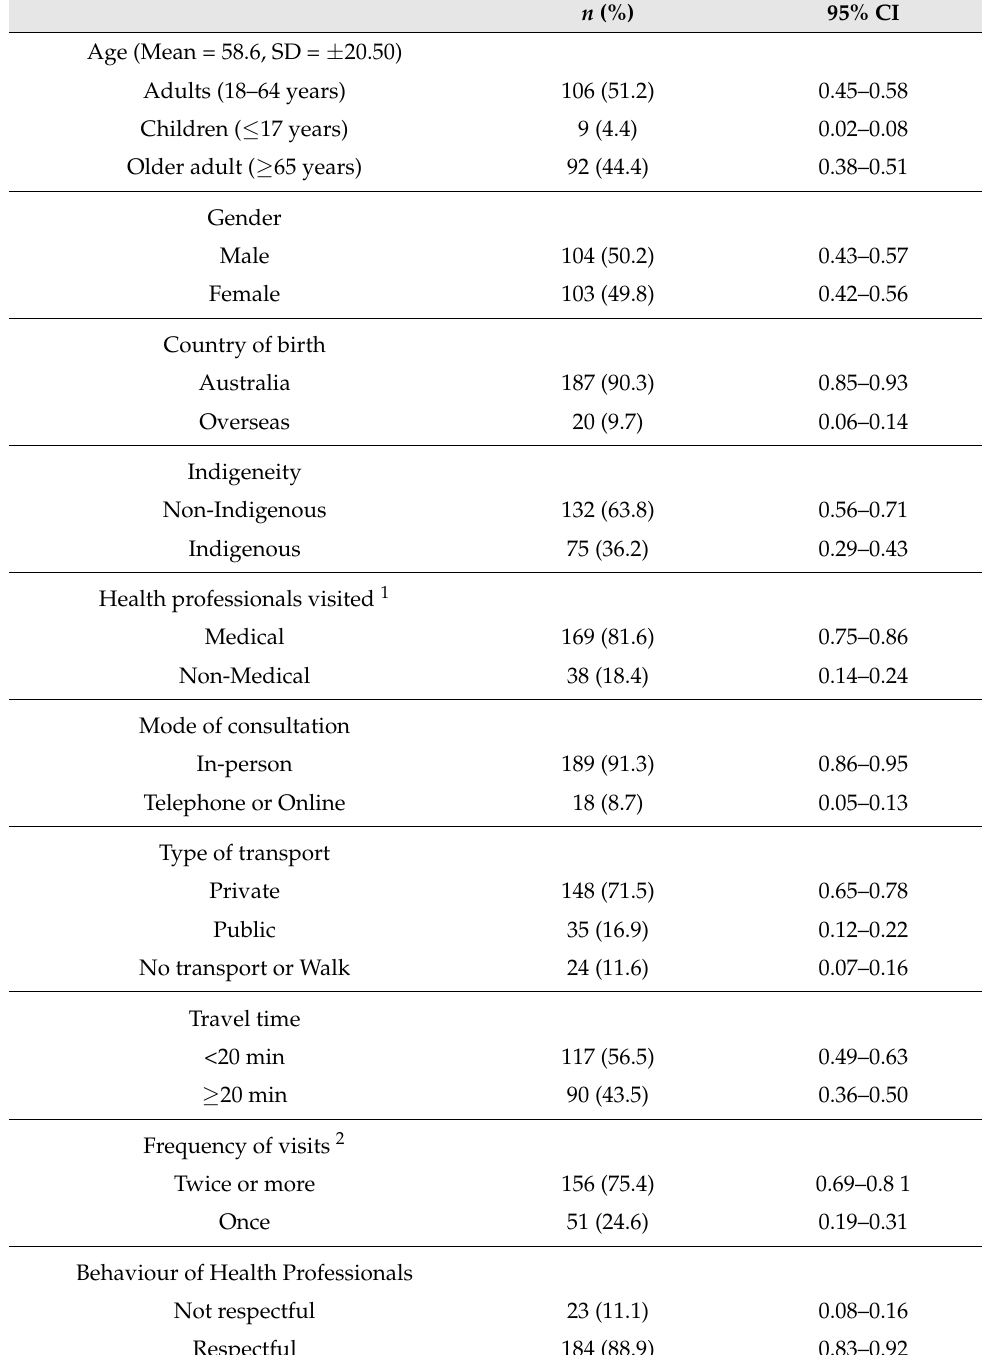
Table 1. Sample characteristics ( n =